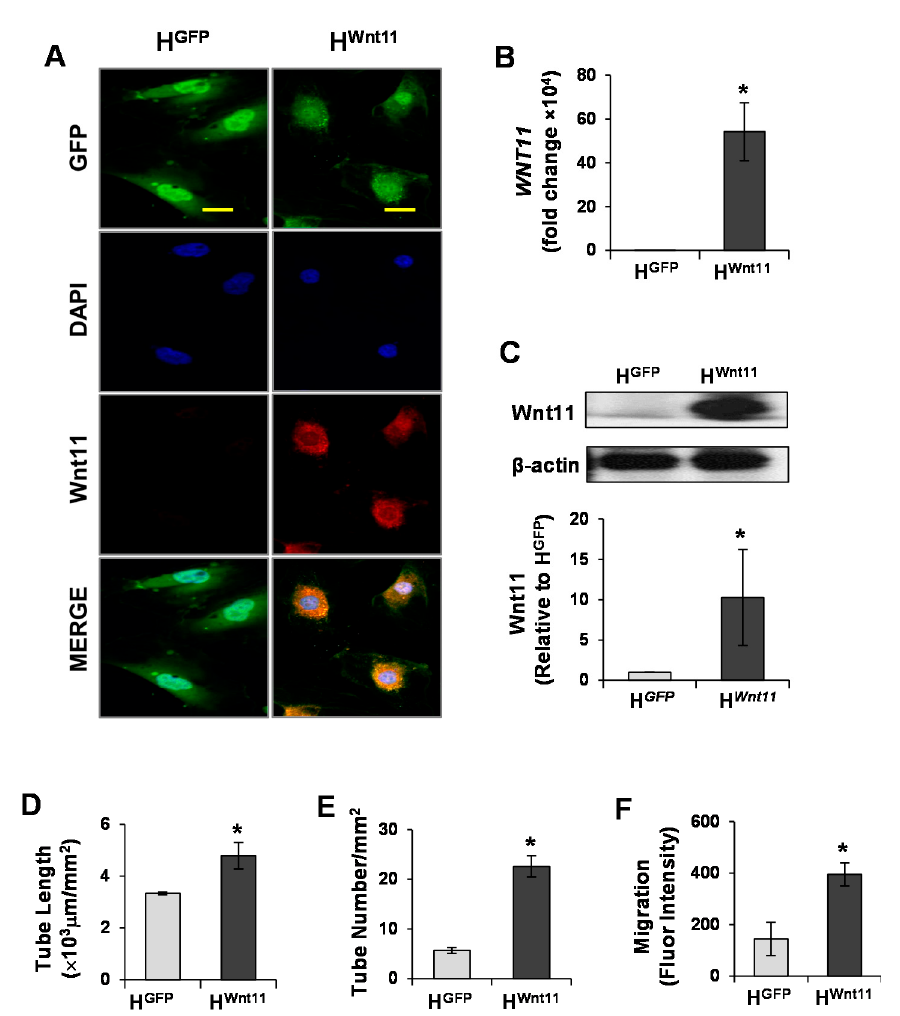
Figure 5. Wnt11 promotes capillary-like tube (CLT) formation and endothelial cell migration. ( A ): HUVECs were directly transduced with Wnt11 using retroviral-mediated Wnt11 / GFP bicistronic construct and then subjected to immunostaining with Wnt11 (Red) and GFP (Green). Nuclei were counterstained with DAPI (blue). The scale bars represent 50 µ m. ( B ): RT-PCR showed that the mRNA of Wnt11 was significantly increased in HUVECs transduced with Wnt11 (H Wnt11 ). ( C ): Western blot showed the relative expression of Wnt11 normalized to β -actin in each sample and compared with the levels in HUVECs transduced with GFP (H GFP ). ( D , E ): CLT formation of H GFP and H Wnt11 . ( F ): HUVEC migration. *, p < 0.05 vs. H GFP .